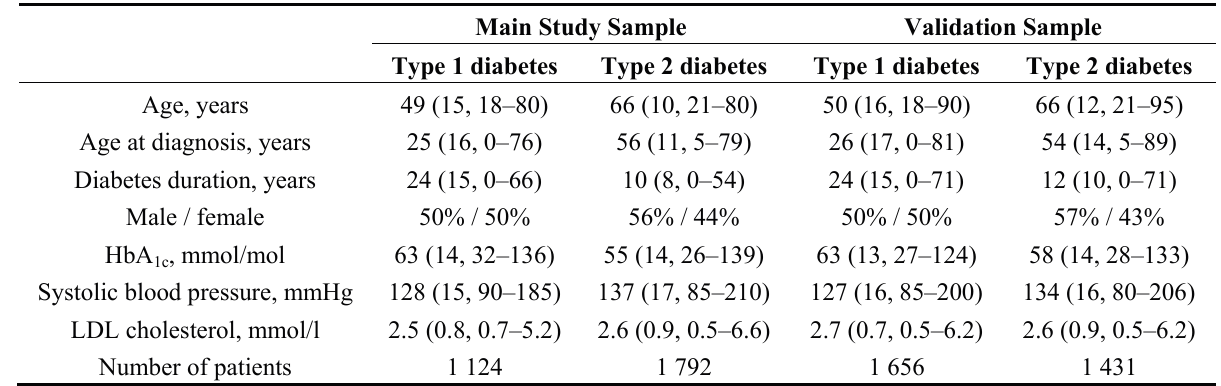
Table 1. Patient sample characteristics by diabetes type in the main study sample and in the validation